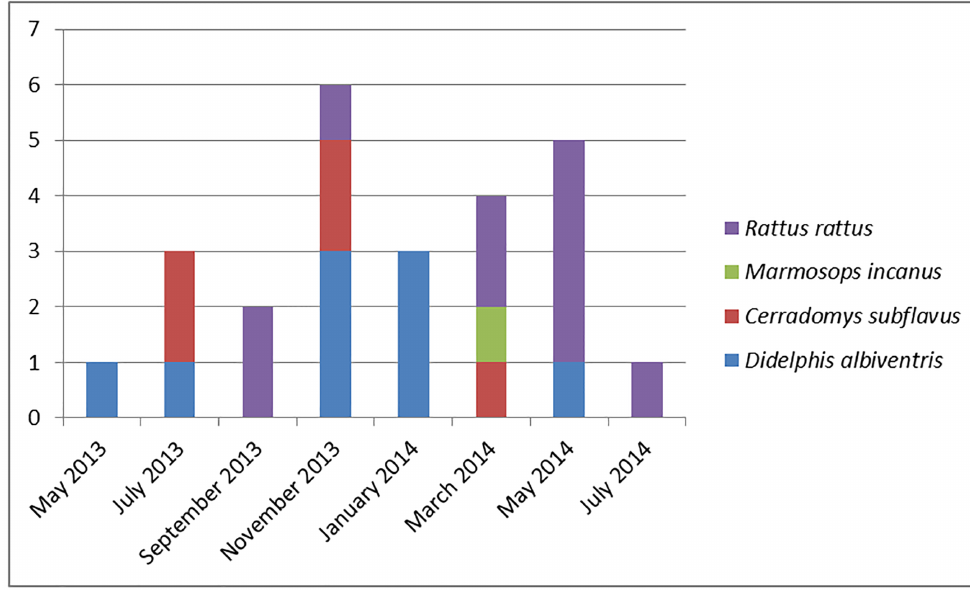
Fig 1. Number of specimens captures by species and campaign (May 2013 to July 2014) in Casa Branca, Brumadinho, MG,